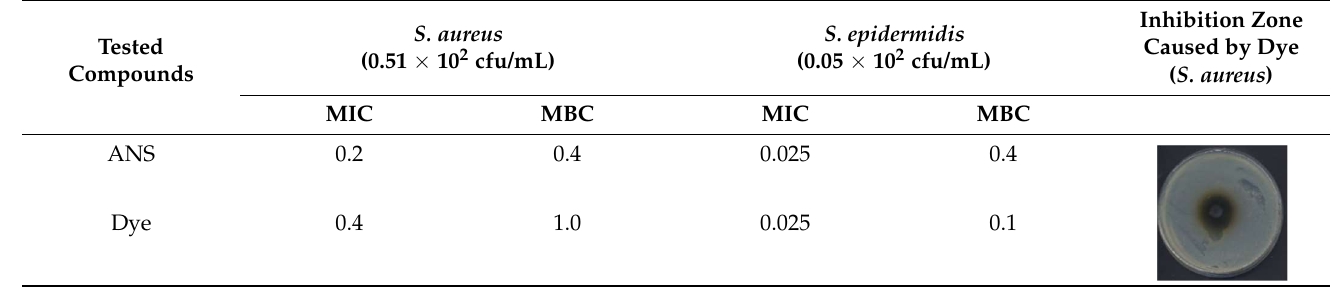
Table 4. Antibacterial potential of the tested substrate (ANS) and dye expressed in mg/mL as the minimal inhibitory concentration (MIC) and the minimal bactericidal concentration (MBC).